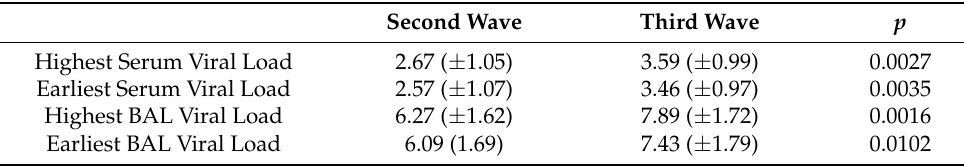
Table 3. Second vs. third wave viral load (log converted) (mean ±